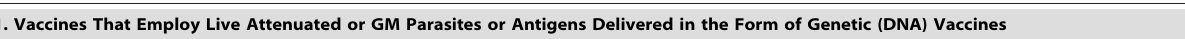
Table 1. Questions and issues raised at the International Symposium on Leishmaniasis Vaccines, and proposals for action through a research